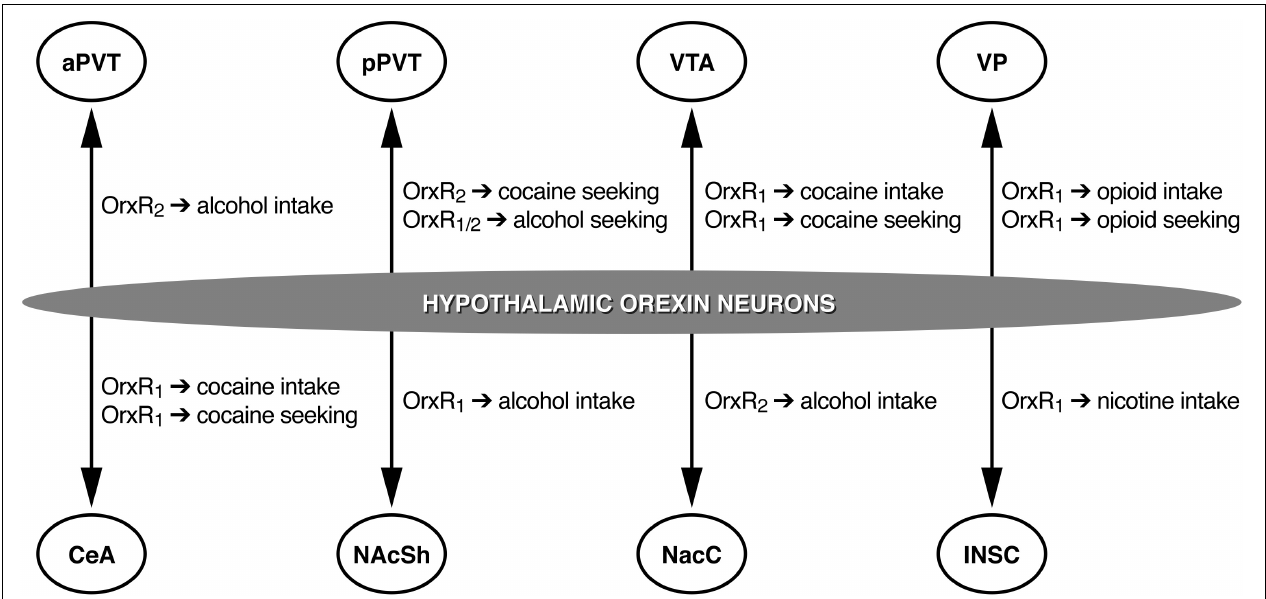
FIGURE 1 | Schematic representation of the roles of different OrxR subtypes in different brain regions. aPVT, anterior paraventricular nucleus of the thalamus; pPVT, posterior paraventricular nucleus of the thalamus; VTA, ventral tegmental area; VP, ventral pallidum; CeA, central nucleus of the amygdala; NAcSh, nucleus accumbens shell; NAcC, nucleus accumbens core; INSC, insular cortex. Arrows represent Orx